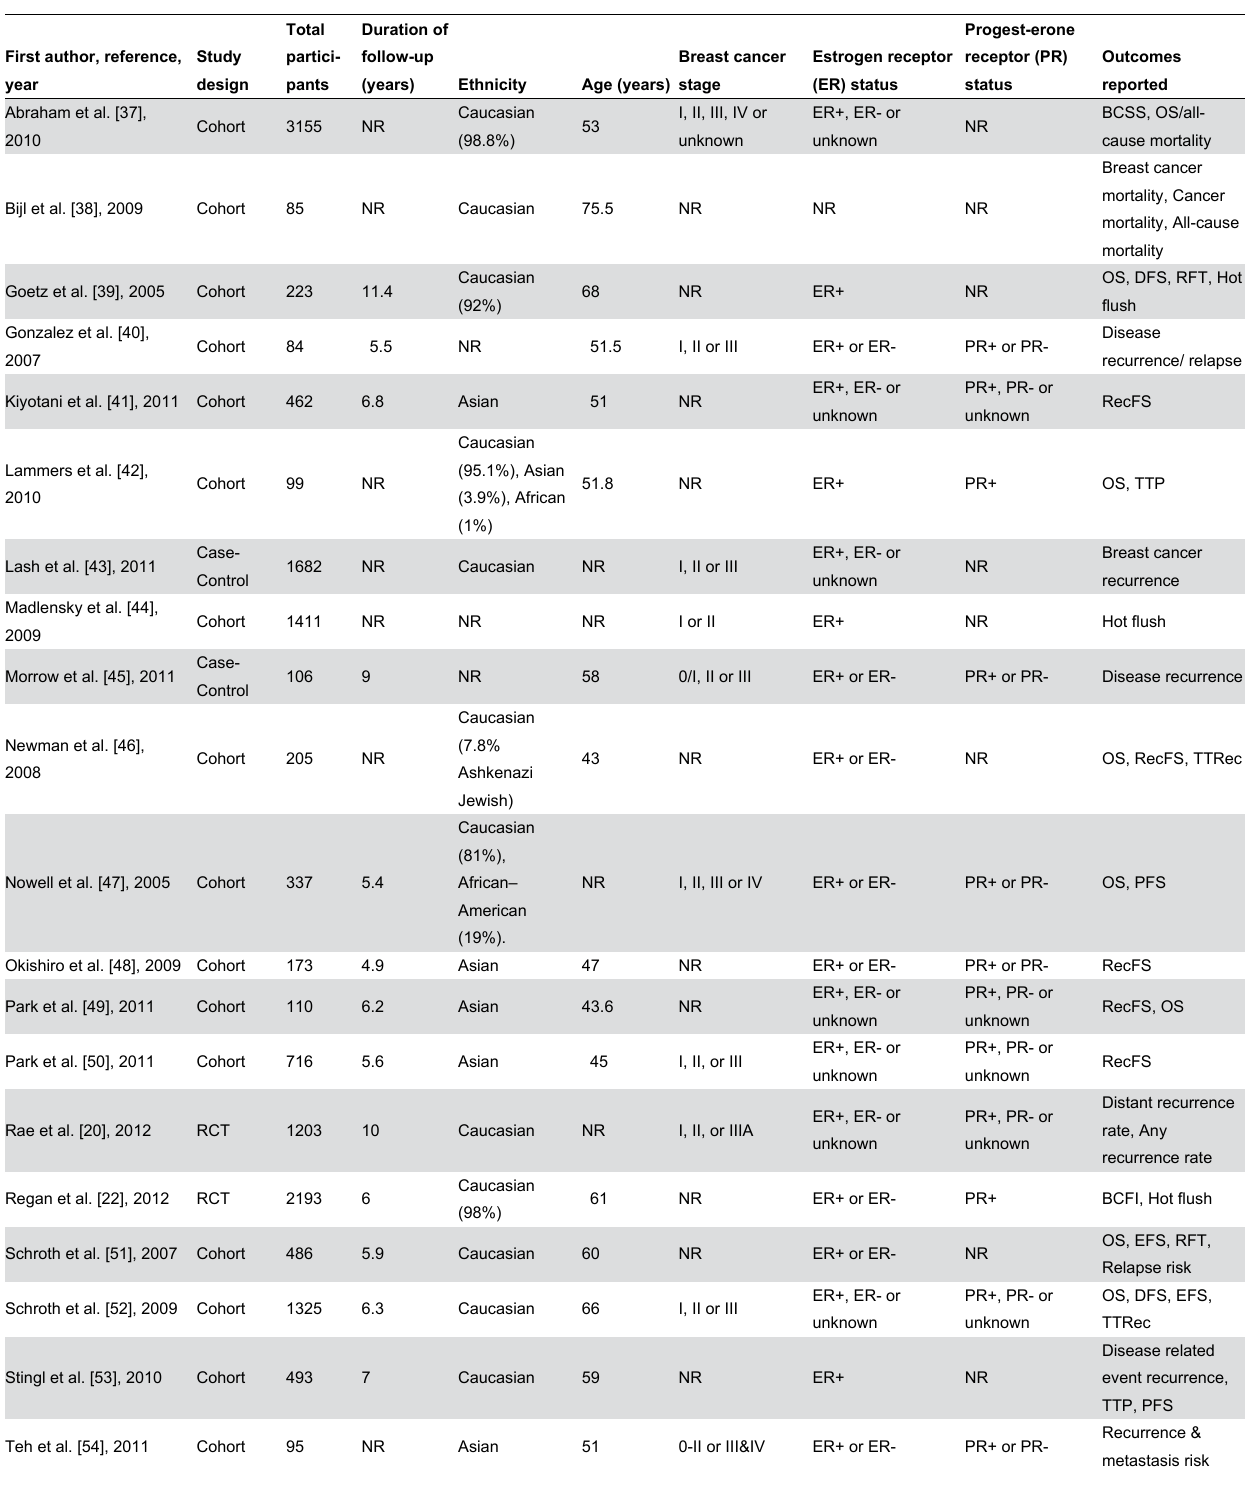
Table 1. Characteristics of the 25 studies identified by the systematic